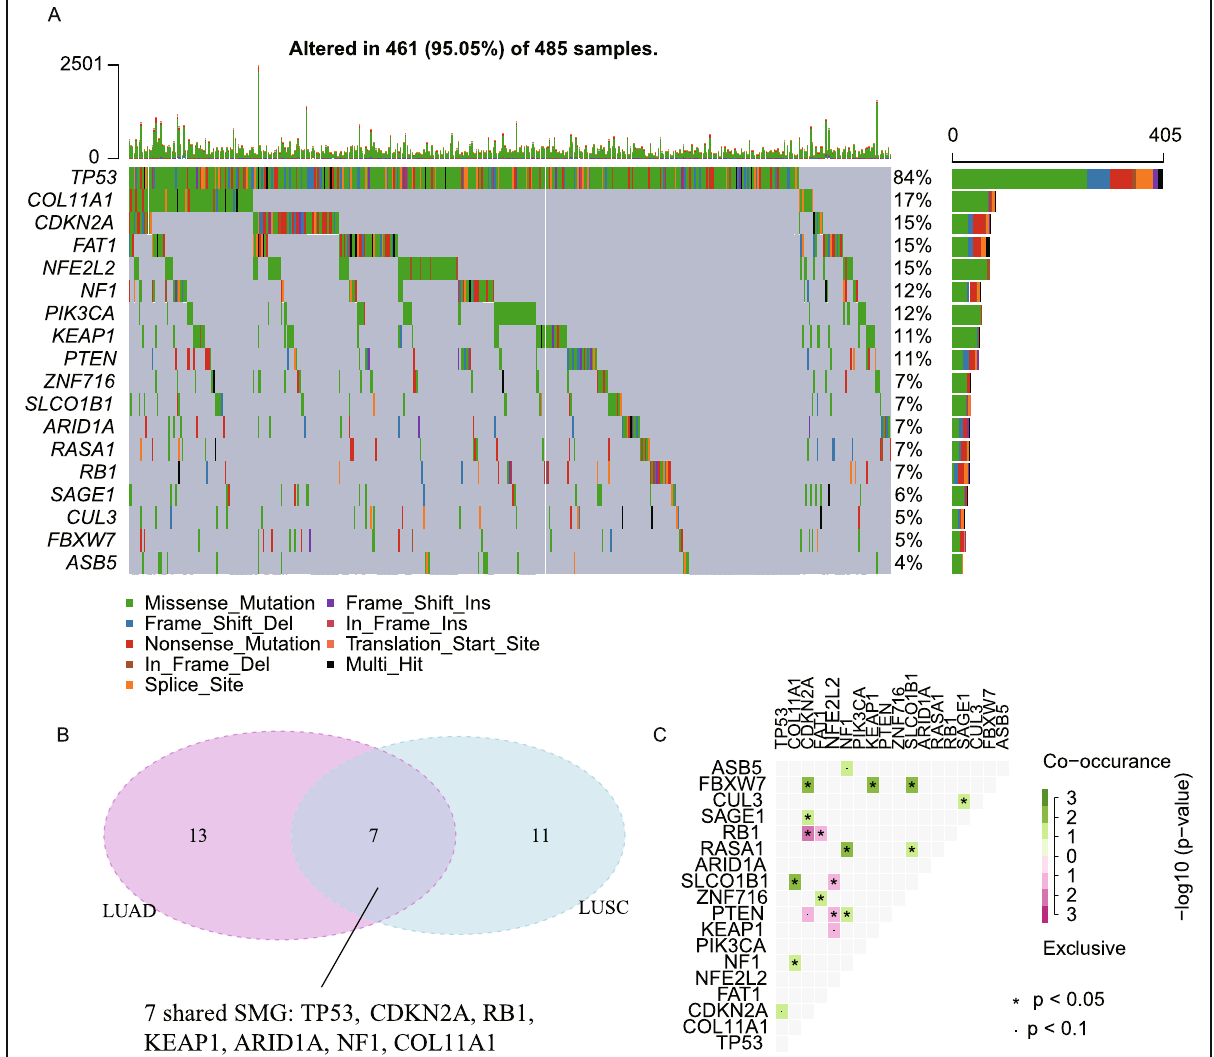
Fig. 1 Significant somatic gene mutations in TCGA LUSC. a . Oncoplot of SMGs in LUSC. b . Overlapped SMGs between LUSC and LUAD. c . Interactions within the